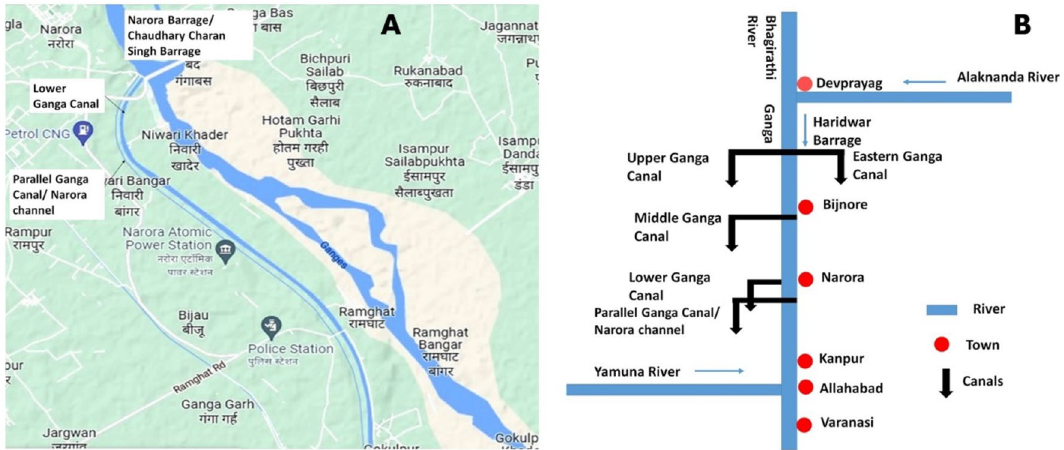
Figure 4. ( A ) Map of study site showing Narora channel; ( B ) Schematic representation of canal system of river